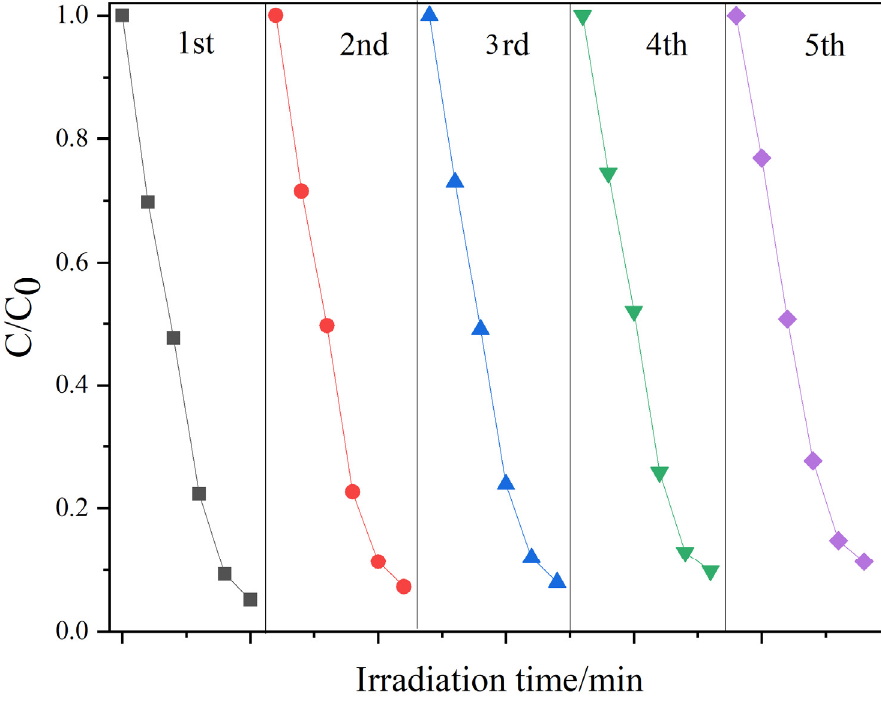
Figure 7. Recyclability of RhB photodegradation with γ -Fe 2 O 3 /WO 3 ·0.5H 2 O.